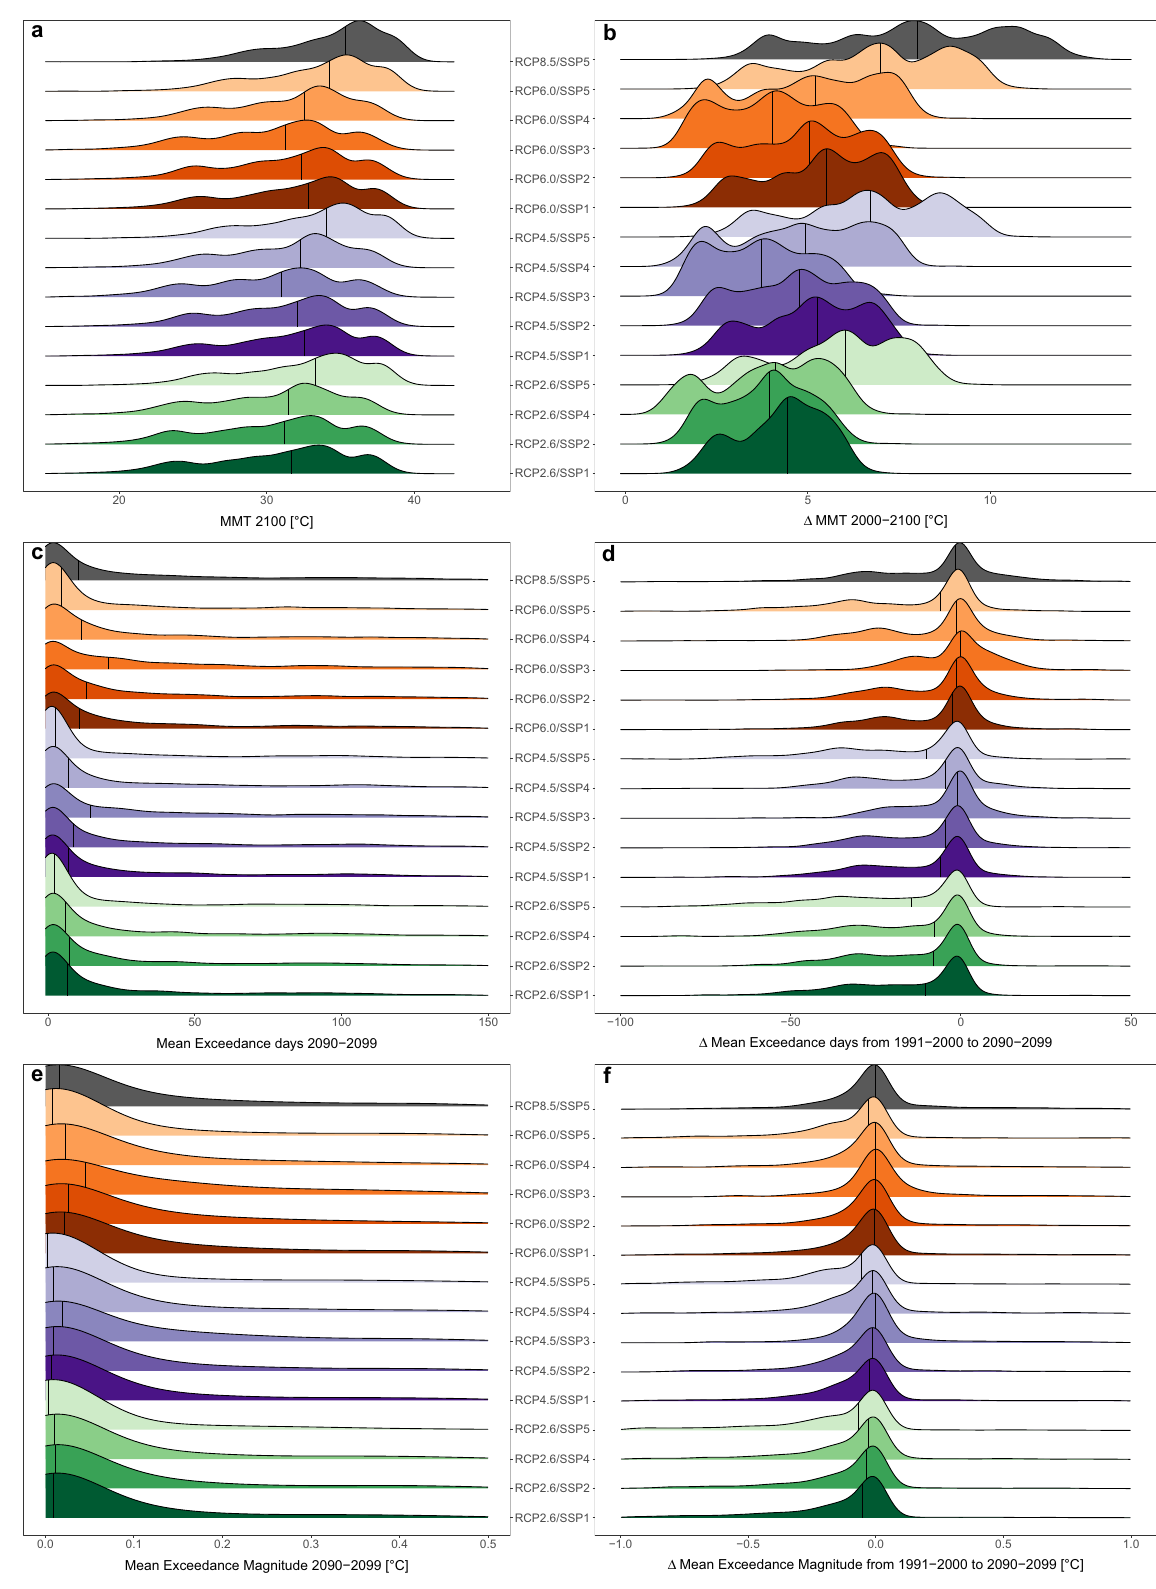
Figure 1. Distributions of studied adaptation and exposure parameters for the RCP/SSP combinations. Absolute MMT for 2100 ( a ), 2090–2099 exceedance days EXD ( c ), 2090–2099 exceedance magnitude MAG ( e ). Parameter changes are (cid:31) MMT 2000–2100 ( b ), and exposure from 1991–2000 to 2090–2099: (cid:31) EXD ( d ), (cid:31) MAG ( f ). Vertical lines indicate the distributions’ medians. Distributions ( c–f ) were